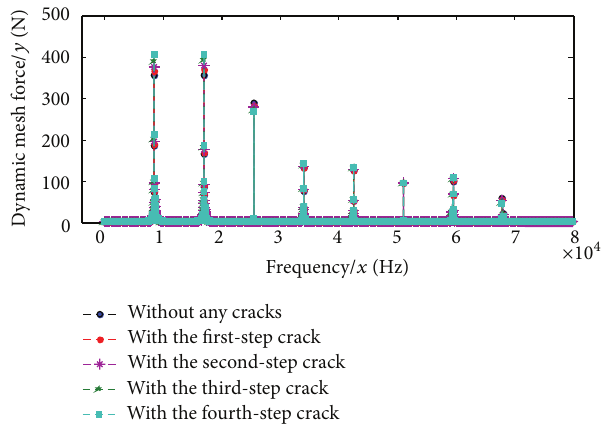
Figure 12: The simulation of dynamic mesh forces of the example case.